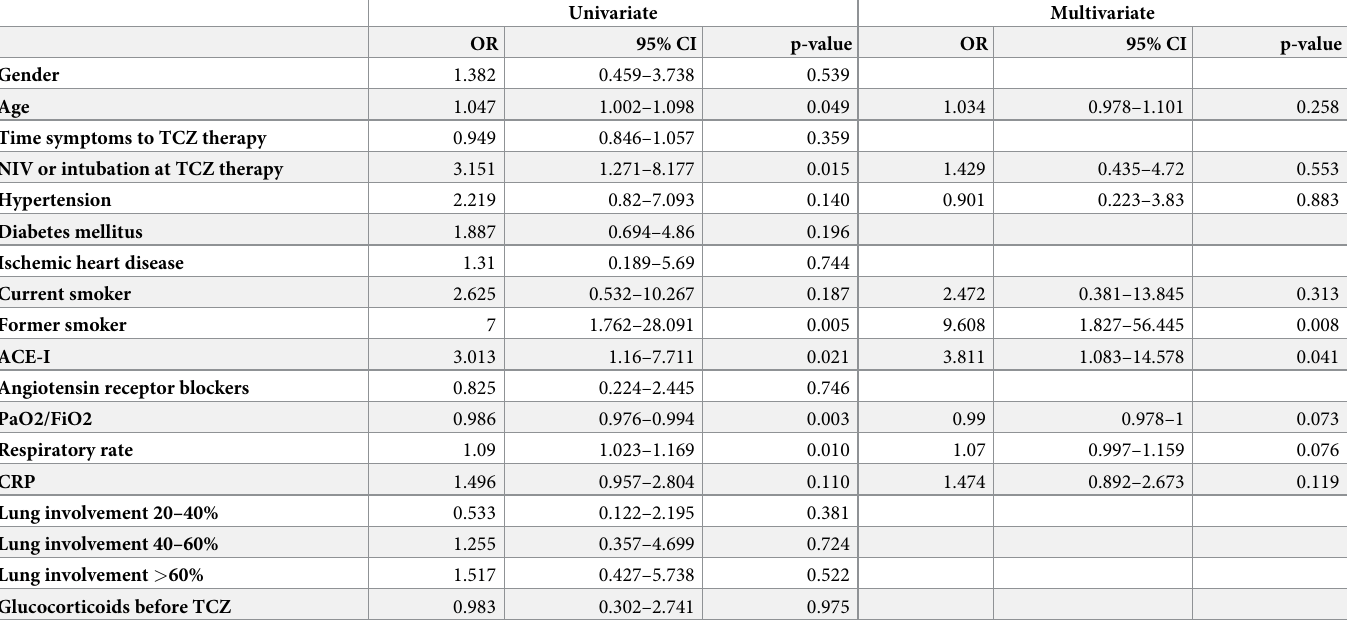
Table 3. Clinical, serological and radiological features associated with death or